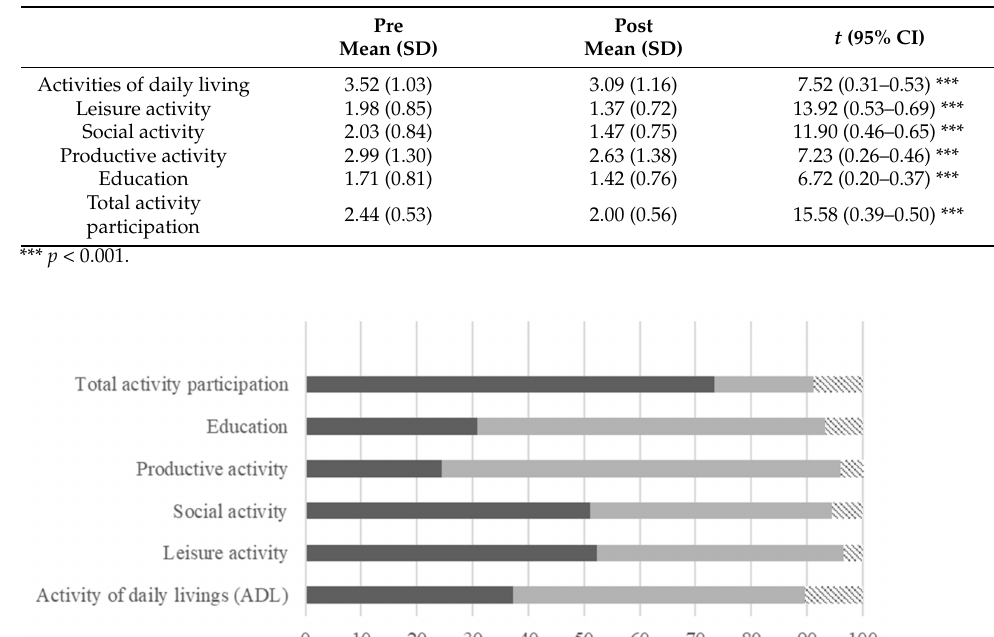
Table 3. Self-reported activity participation of periods pre and post COVID-19 pandemic which were assessed via a single questionnaire collected post COVID-19 pandemic ( n = 327).